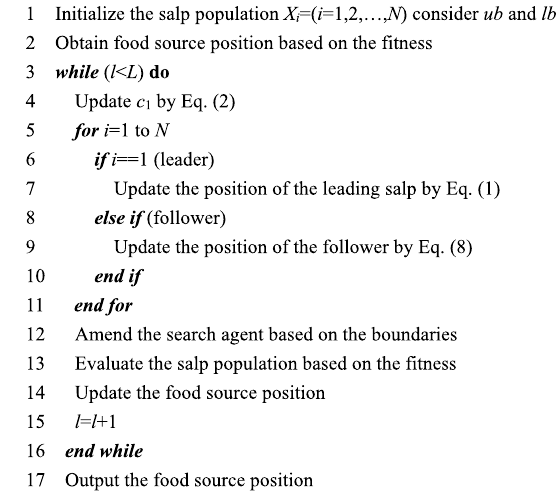
Algorithm 1 outlines the pseudo code of the basic SSA.